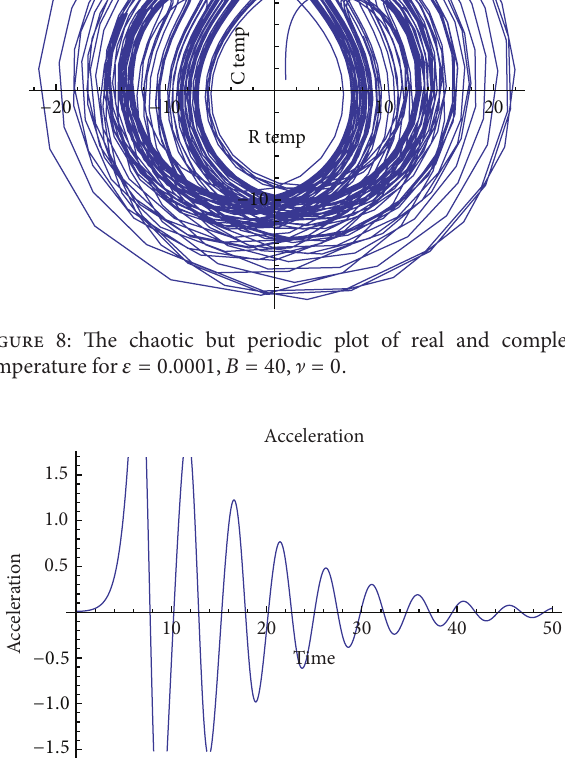
Figure 9: The stabilizing process of acceleration for ] = 1,𝜀 = 5, 𝐵 = 1000, ] ̸=0 .